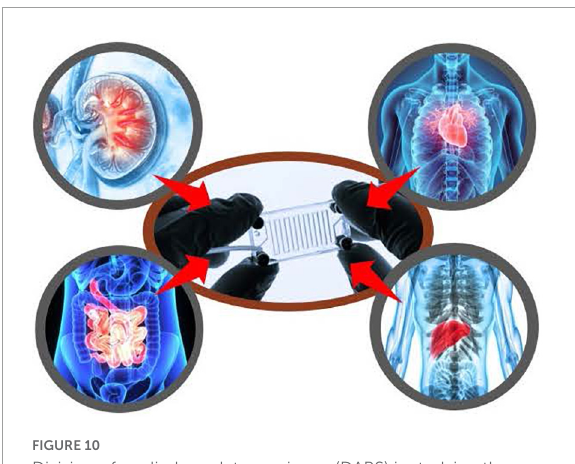
FIGURE10 Division of applied regulatory science (DARS) is studying the utility of complex in vitro models, including with induced pluripotent stem cells (iPSCs) and microphysiological systems to reduce and replace animal testing.